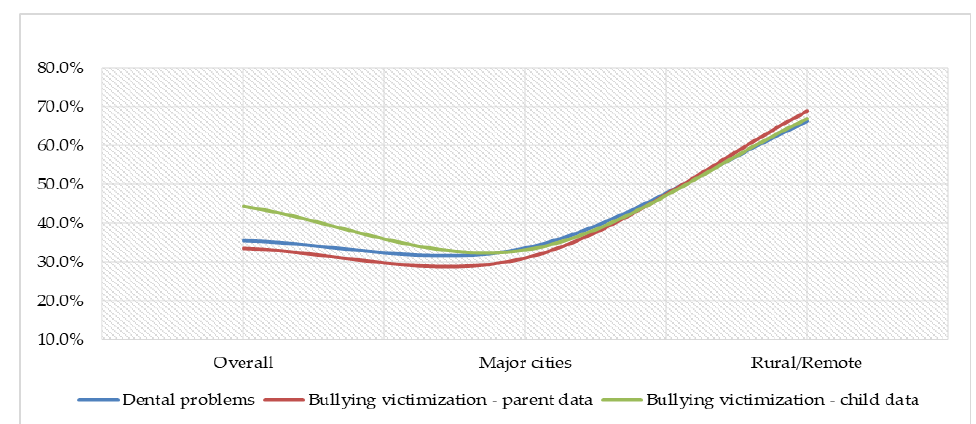
Figure 2. Prevalence (%) of dental problem and bullying victimization.